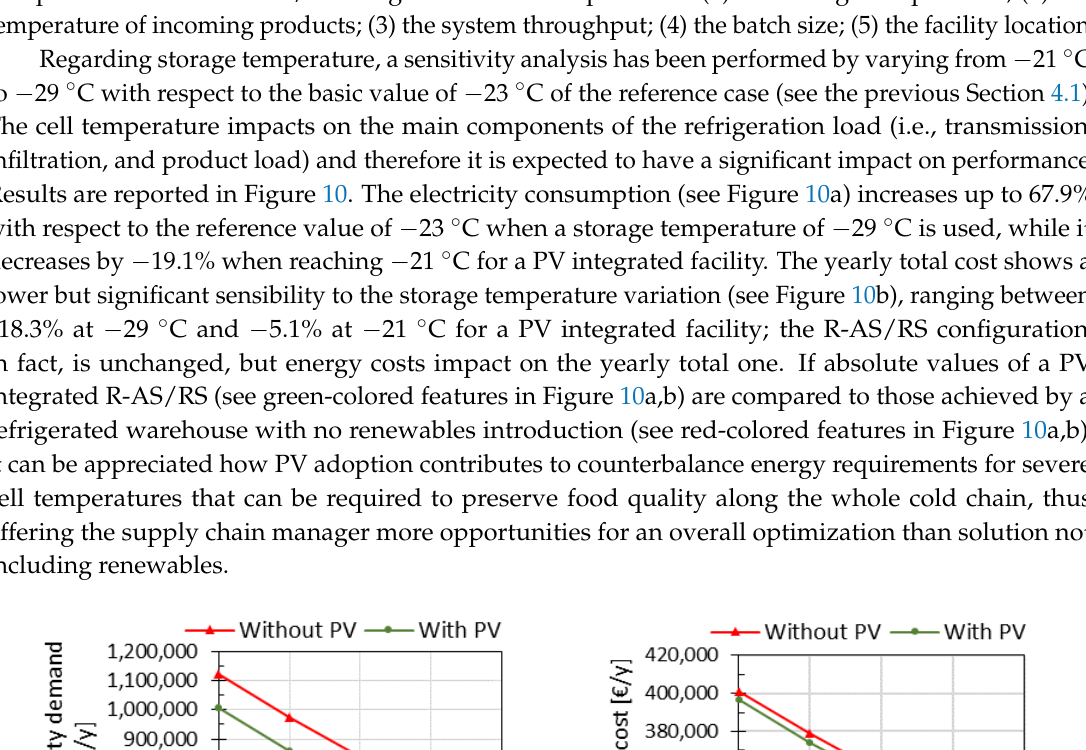
( b ) Figure 11. Sensitivity analysis on product temperature: ( a ) electricity withdrawal from the grid and ( b ) yearly total cost. Figure 12a shows how the system throughput affects the grid electricity demand when yearly total cost is minimized, and a PV plant is used. System throughput affects the infiltration load due to the different number of door openings to bring unit loads into the storage space, the product load due to different number of products whose temperature has to be increased to the storage one, and energy requirements for movement equipment (i.e., cranes, satellites, and trucks, with related internal load also). It is worth noting that the variation of the grid electricity demand is not linear but shows a sudden increase between 51 and 52 cycles per hour and then a rapid decrease between 56 and 57 cycles per hour. A similar behavior occurs in the yearly cost shown in Figure 12b, with the difference that the rapid variations lead always to increasing costs. Such patterns can be explained by analyzing the rack configuration of the optimized storage facility reported in Table 5. When varying the system throughput, the CP solver finds basically three warehouse configurations. The first configuration, which ranges from 15 to 51 cycles per hour, is composed by 25 columns, 6 levels,